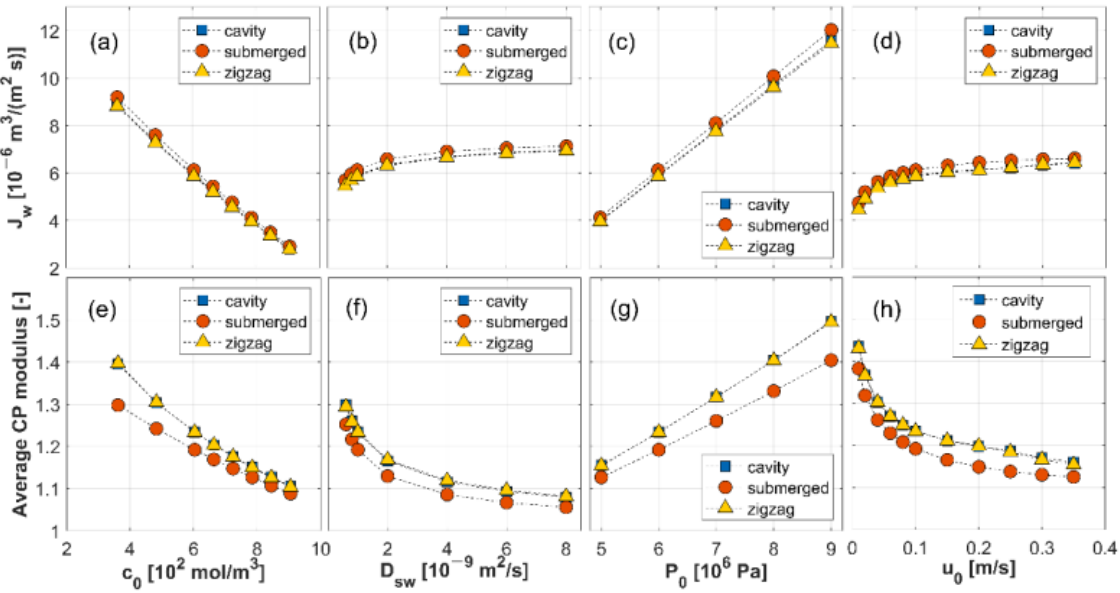
Figure 3. Average water fluxes (top) and CP moduli (bottom) in the cavity, submerged and zigzag configurations for varying inlet concentration c 0 ( a , e ), diffusivity of solute in water D sw ( b , f ), outlet pressure p 0 ( c , g ), and inlet velocity u 0 ( d , h ).